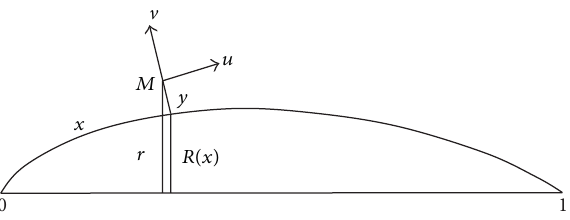
Figure 2: Boundary layer on a slender rotationally symmetric